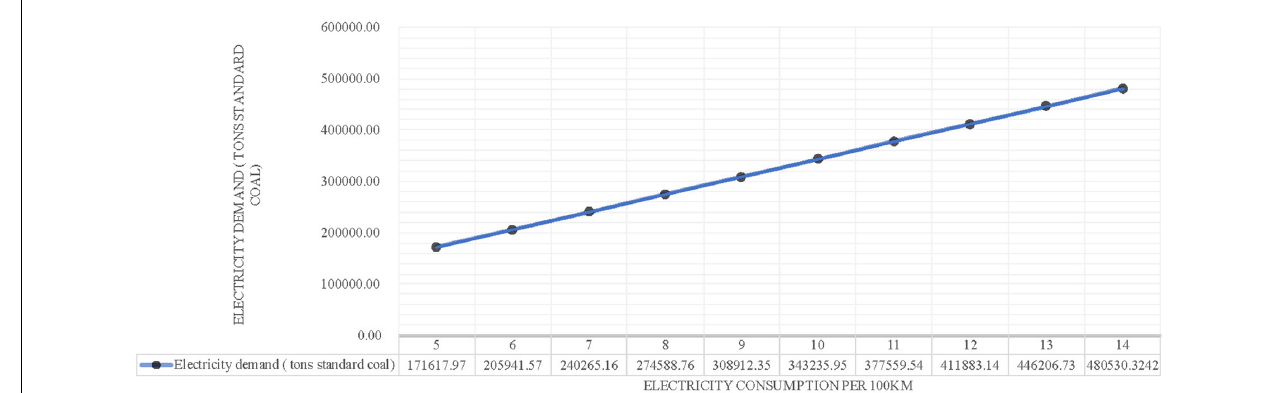
FIGURE 4 | Relationship between electricity demand and the technology in